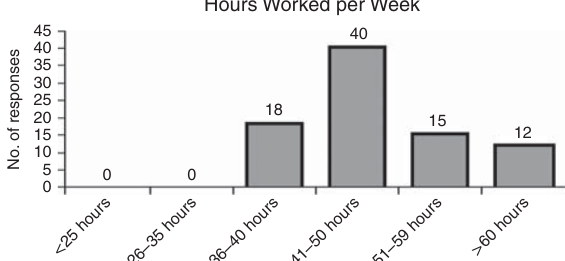
Figure 3. Hours worked per week of participants as reported